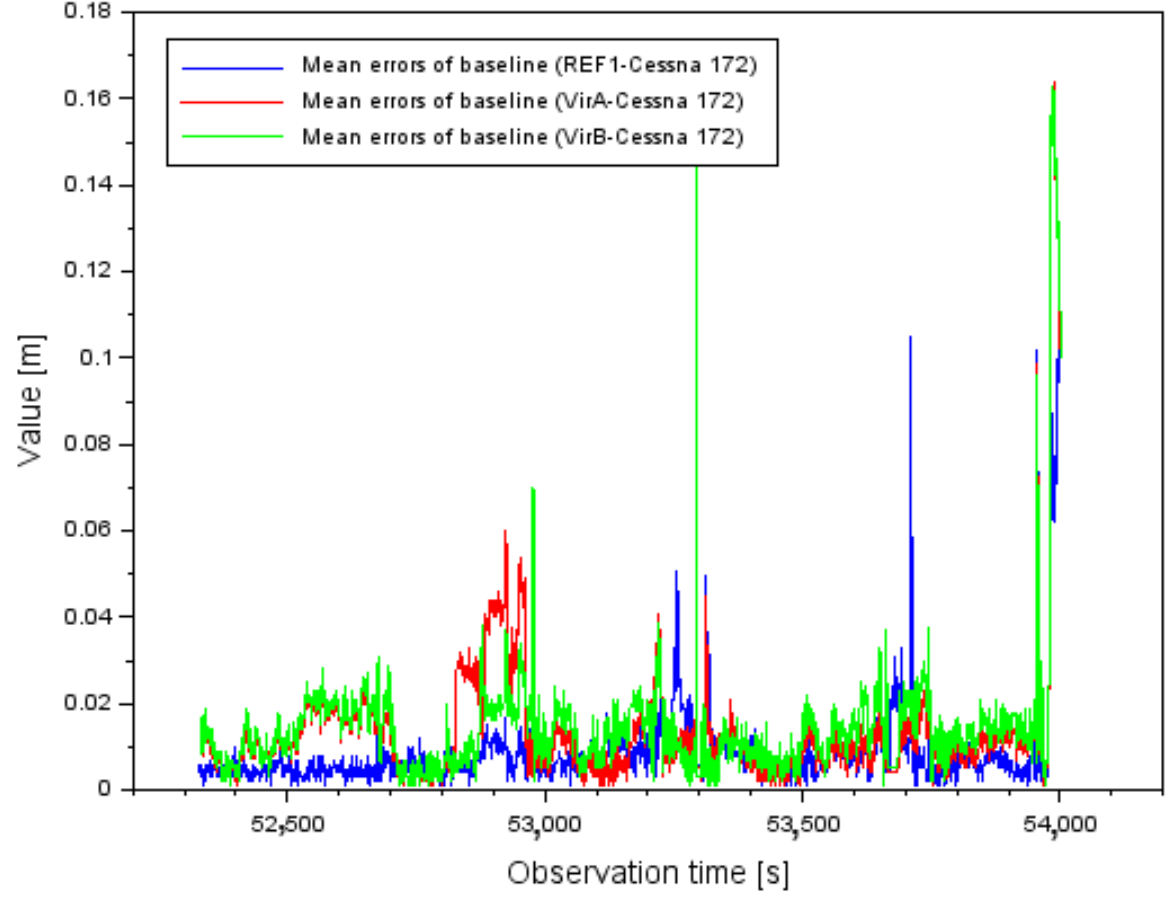
Figure 2. Mean 3D errors for each baseline.